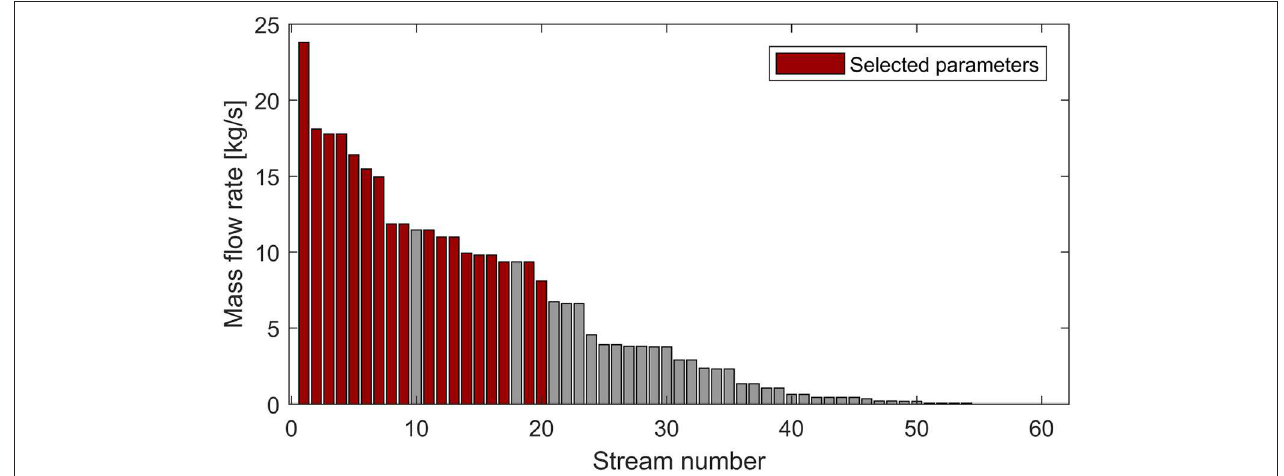
FIGURE 12 | Stream mass flow rates sorted in descending order. Red bars indicate the streams selected for detailed measurement.